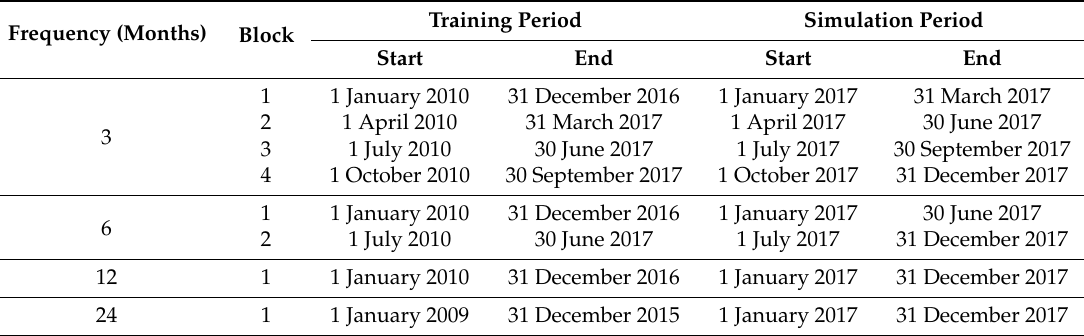
Table 1. Training and simulation periods used for testing the effect of training